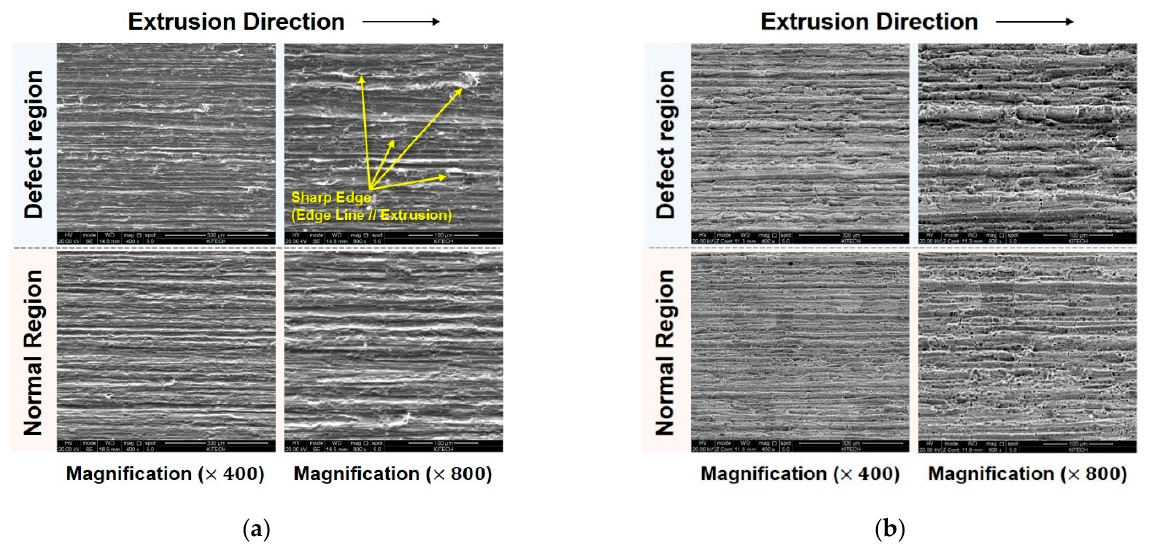
Figure 20. Surface roughness evaluation of the defective and normal regions: ( a ) before; and ( b ) after eliminating the anodic oxide layer.